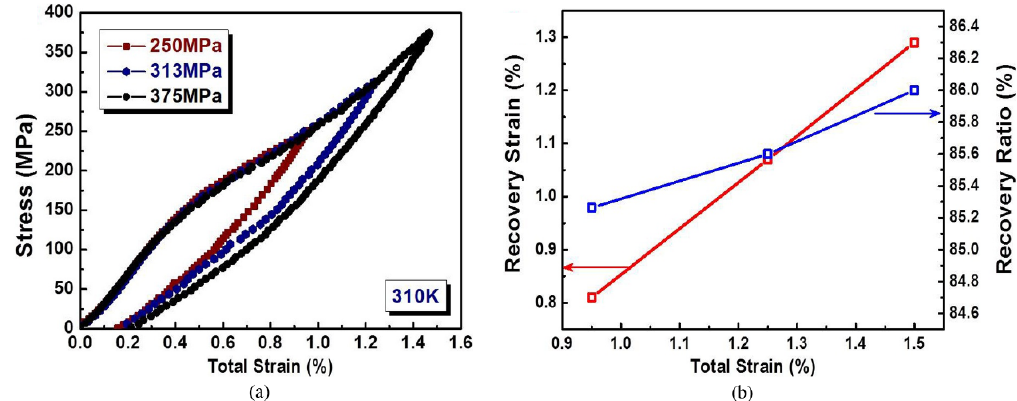
Figure 5. (a) Tensile stress-strain curves under different loadings at the same temperature of 310 K, (b) recovery strain and recovery ratio vs total strain of as-extracted